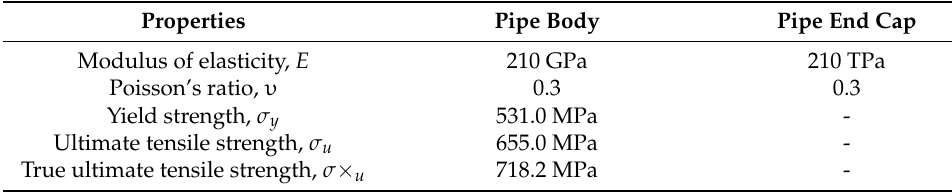
Table 5. Mechanical properties of the API 5L X80 [21].